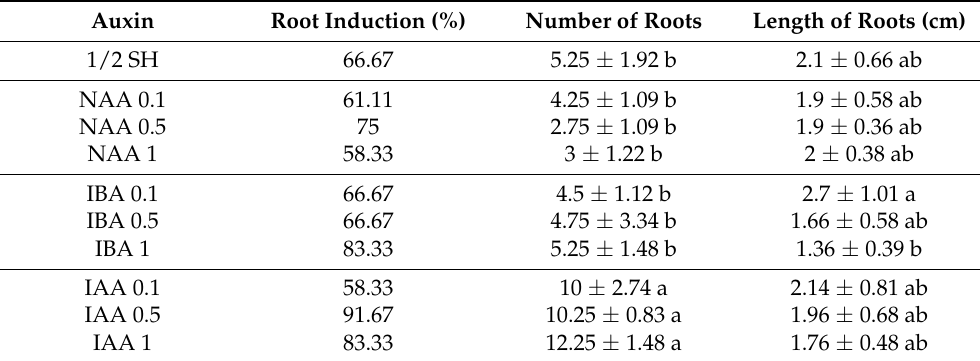
Table 1. Effect of different types of auxins on adventitious root induction from hypocotyl explants of F. tataricum